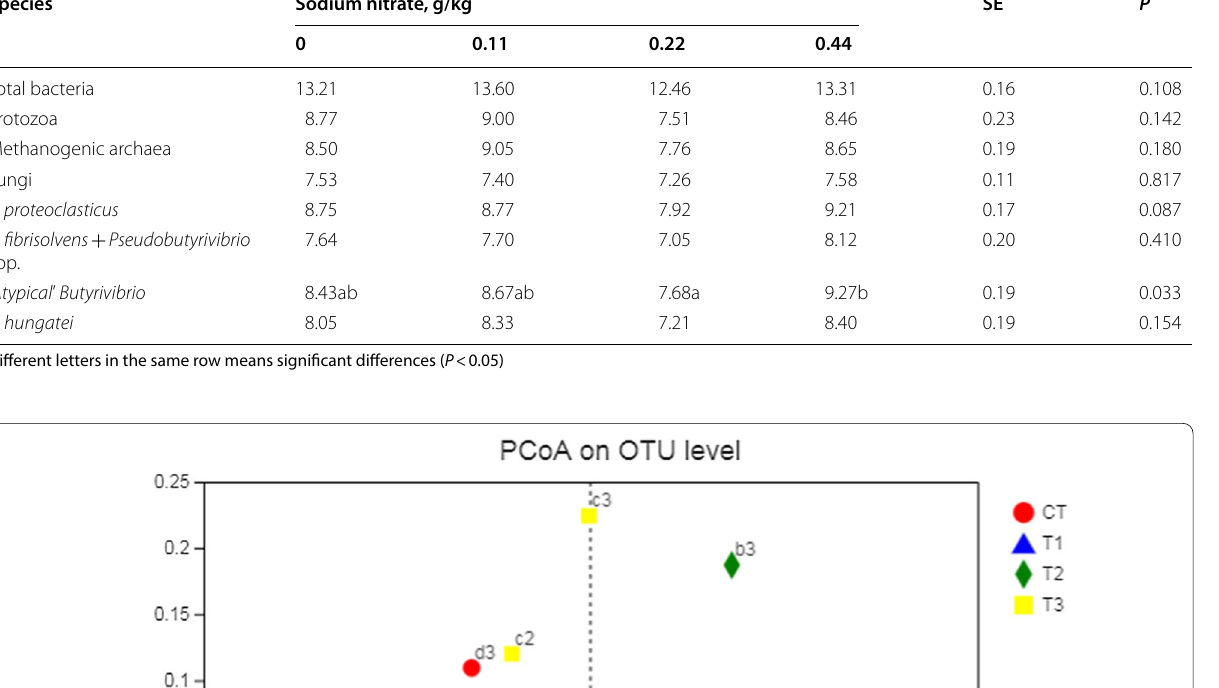
Table 9 Effects of sodium nitrate on microbial population in water buffaloes (log